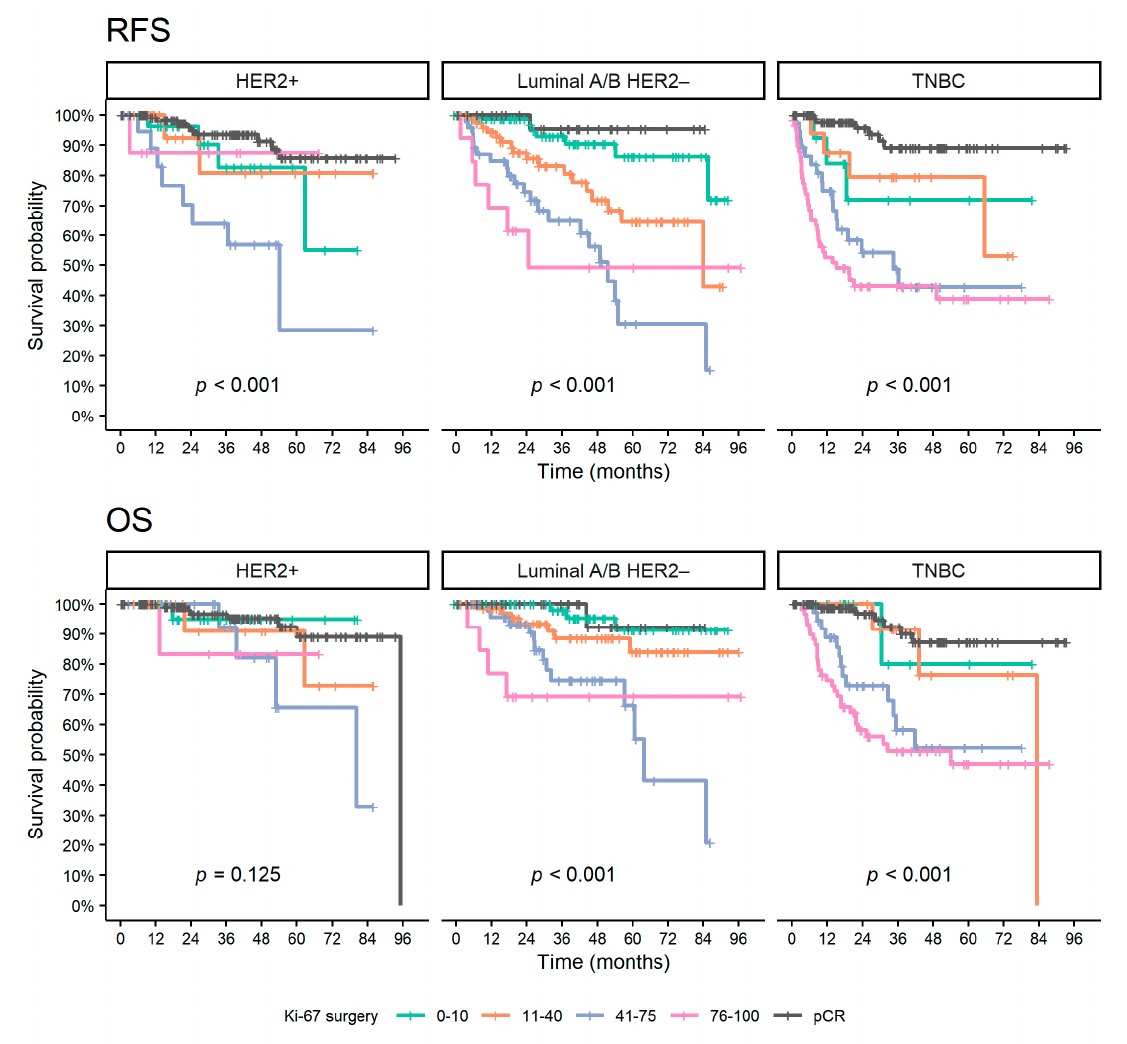
Figure 4. Kaplan–Meier curves of survival outcomes for patients with aRCB according to Ki-67 surgery and patients with pCR. Abbreviations: pCR, pathological complete response; OS, overall survival; RFS, relapse-free survival; HR, hazard ratio; CI, confidence interval; TNBC, triple-negative breast cancer; HER2, human epidermal growth factor receptor